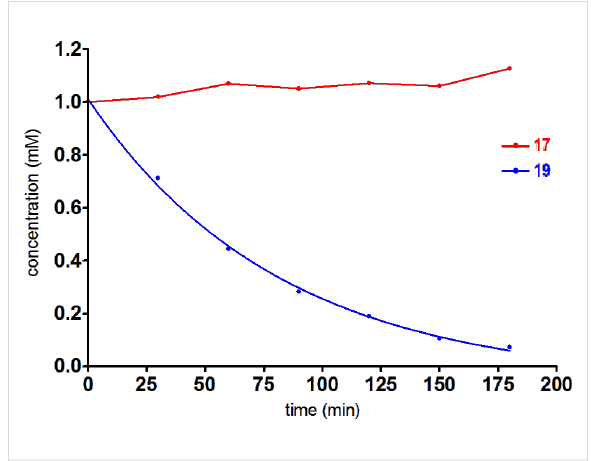
Figure 6: Time course of the carboxylesterase-catalysed degradation of 3-fluoropropansulfonamide 17 (red) and fluoroacetamide 19 (blue). The pseudo first-order rate constant for the decay of 19 was (0.012 ± 0.001) min − 1 corresponding to a half-life of 57.8 min. Data points represent average values from two measurements originating from two independent experiments with SEM values less than 10% of the mean